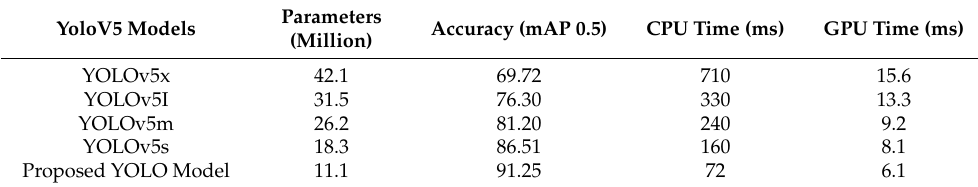
Table 3. Comparative analysis performance of time complexity on Yolov5 models. YoloV5